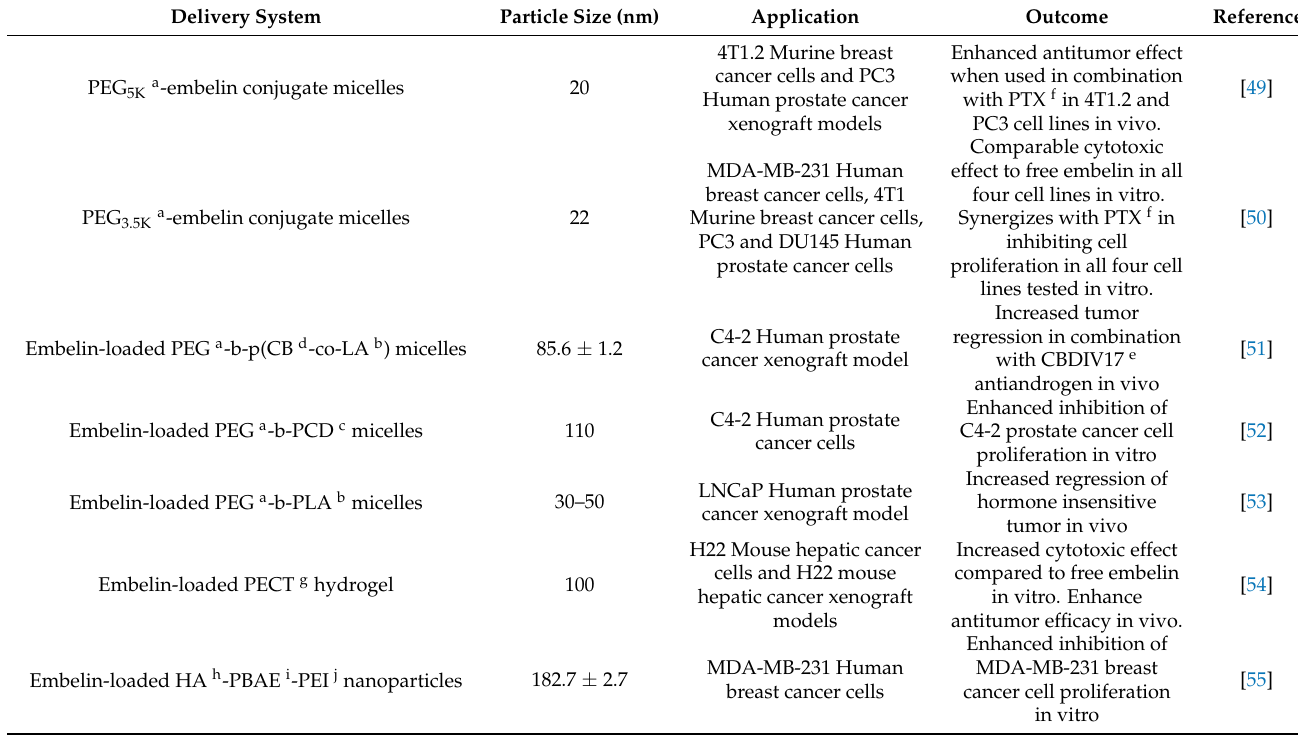
Table 1. Examples of embelin delivery